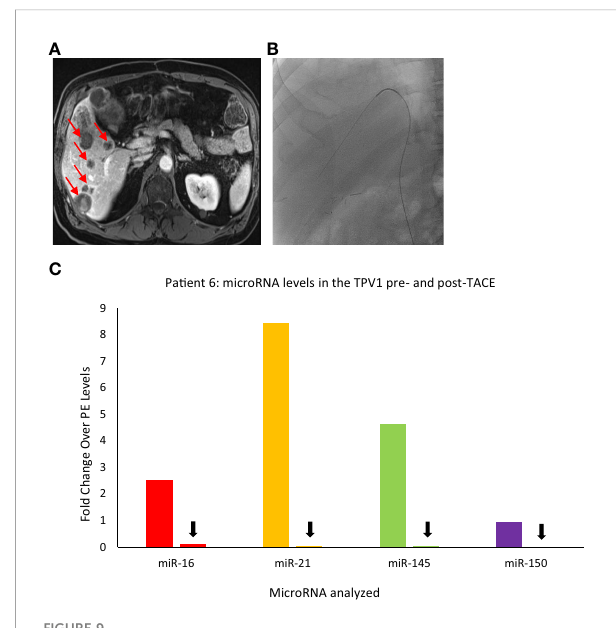
FIGURE 9 Images of Patient 6 ’ s liver metastasis (A) , intra-procedural catheter access (B) , and microRNA analysis of TPV samples pre- and post- trans-arterial chemoembolization (TACE) (C) . miR-16, miR-21, miR- 145, and miR-150 levels were higher in the right hepatic vein (RHV, the TPV1 for the liver mass) before TACE and dropped down after TACE. For this patient, pre- and post-TACE levels in the left common femoral vein (LCFV) were similar for all miRNAs tested (data not shown), and therefore, LCFV was considered equivalent to to a peripheral vein (PE). Data is shown as fold change over pre- TACE PE levels for each miRNA assayed. All samples are from the microsomal RNA 2500P fraction. Red arrows in (A) indicate some of the metastatic masses in the liver and black arrows in (C) indicate drop in post-TACE levels of microRNAs in the TPV1